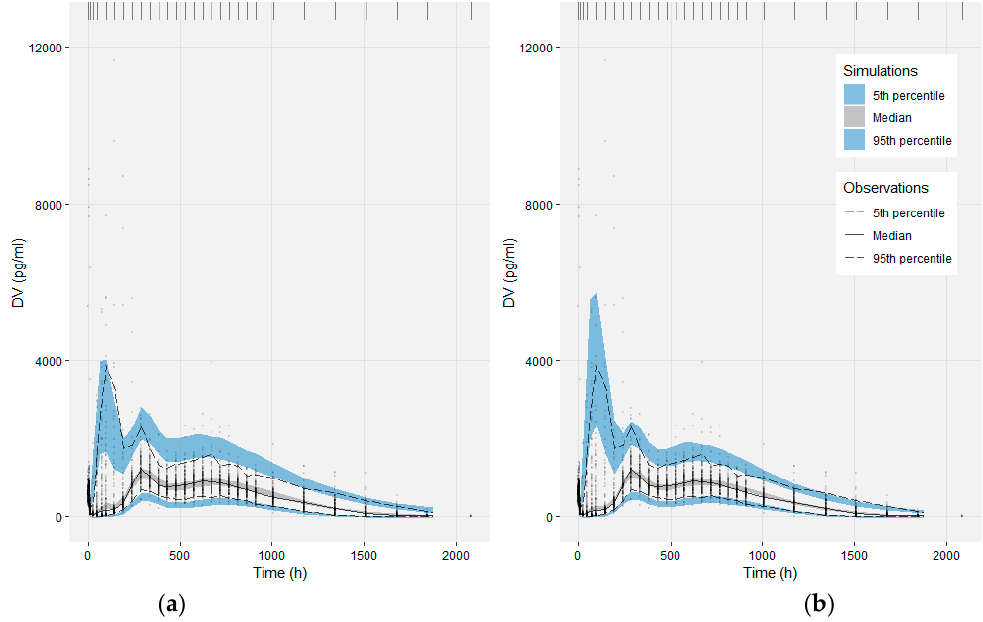
Figure 4. Visual Predictive Checks of the base model ( a ) and the final model ( b ). The median, 5th and 95th percentiles of the observations (lines) are compared with the corresponding 95% confidence intervals of the 1000 simulated datasets (shaded areas).